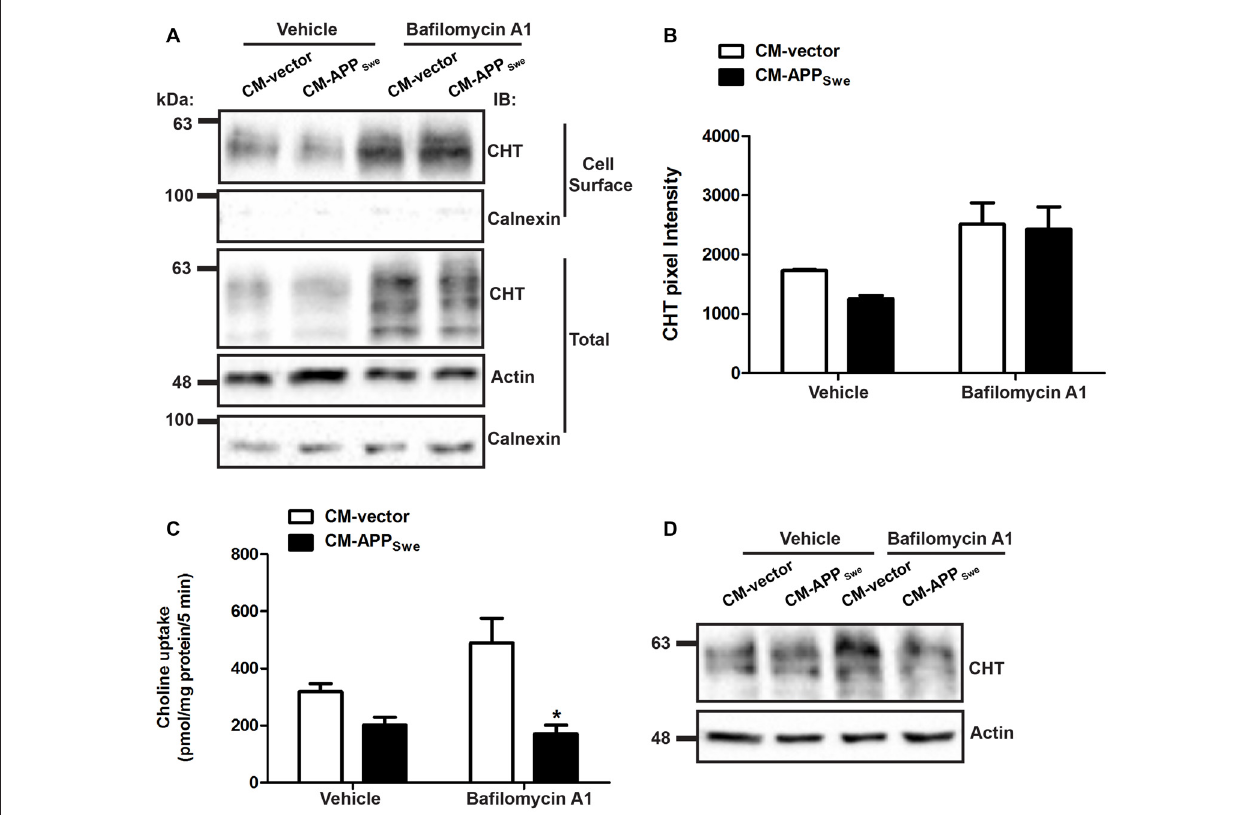
FIGURE 7 | BafA 1 blocks an A β -mediated decrease in CHT cell surface expression but not CHT activity. (A) CM was collected from SY5Y-CHT cells that had been transiently expressing either vector or APP Swe plasmid DNA for 24 h (CM-vector and CM-APP Swe , respectively). CM-vector and CM-APP Swe containing either vehicle (DMSO) or 20 nM BafA 1 were added to SY5Y-CHT cells for 24 h. Cells were then washed and placed on ice, and then plasma membrane proteins were biotinylated. Representative immunoblots show steady-state CHT, actin and calnexin protein levels in total cell lysates (3 lower panels). The top panels illustrate cell surface (biotinylated) CHT and calnexin proteins. The immunoblots shown are representative of data obtained from five independent experiments. (B) Analysis of cell surface CHT protein bands by densitometry reveals that the level of CHT protein at the cell surface is reduced in cells treated with CM-APP Swe containing vehicle compared to cells treated with CM-vector containing vehicle. No differences in the level of CHT protein at the cell surface were observed in cells treated with CM-vector containing BafA 1 compared to cells treated with CM-APP Swe containing BafA 1 . Data are the mean ± SEM of five independent experiments, with statistical analyses performed using a two-way ANOVA with Bonferroni post hoc multiple comparisons test ( ∗ p ≤ 0.05). (C) CM-vector and CM-APP Swe containing either vehicle or 20 nM BafA 1 were added to SY5Y-CHT cells for 24 h, and then choline uptake was assayed. CHT activity was reduced in cells treated with CM-APP Swe containing vehicle compared to cells treated with CM-vector containing vehicle. CHT activity was significantly reduced in cells treated with CM-APP Swe containing BafA 1 when compared to cells treated with CM-vector containing BafA 1 . Data are the mean ± SEM of five independent experiments, with statistical analyses performed using a two-way ANOVA with Bonferroni post hoc multiple comparisons test ( ∗ p ≤ 0.05). (D) Representative immunoblots show steady-state total CHT and actin protein levels in total cell lysates from a representative choline uptake